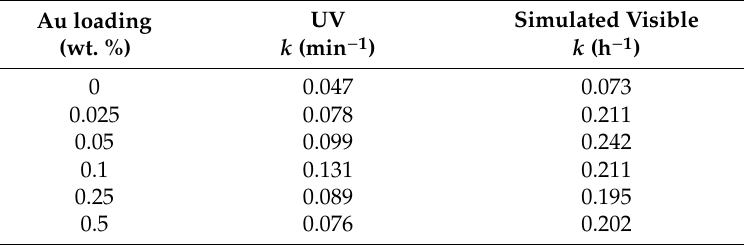
Figure 5. Photocatalytic degradation of ciprofloxacin (5 mg / L) with bare TiO 2 and Au / TiO 2 nanocomposite with di ff erent Au concentrations under 30 and 180 minutes of UV ( a ) and visible ( b ) radiation. The degradation with bare TiO 2 and Au / TiO 2 nanocomposites synthesized at di ff erent temperatures and Au loading of 0.05 wt. % under 30 and 180 minutes of UV ( c ) and simulated visible light radiation ( d ), respectively. Table 1. Apparent reaction rates (k) for photocatalytic degradation of ciprofloxacin (CIP) (5 mg / L) with bare TiO 2 and Au / TiO 2 nanocomposite with di ff erent Au loadings, over 30 and 180 minutes of UV and simulated visible radiation,